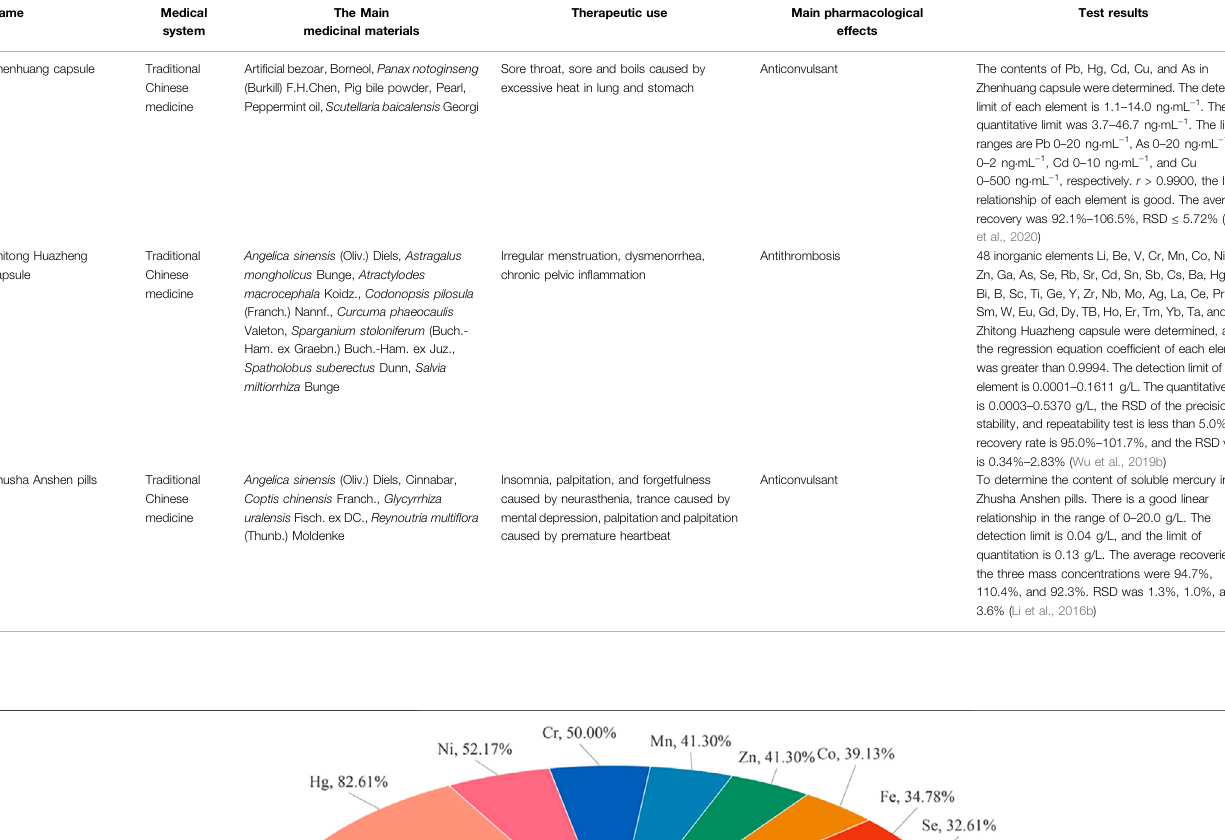
TABLE 10 | ( Continued ) Application of ICP-MS in the determination of heavy metal elements in Chinese patent medicine.